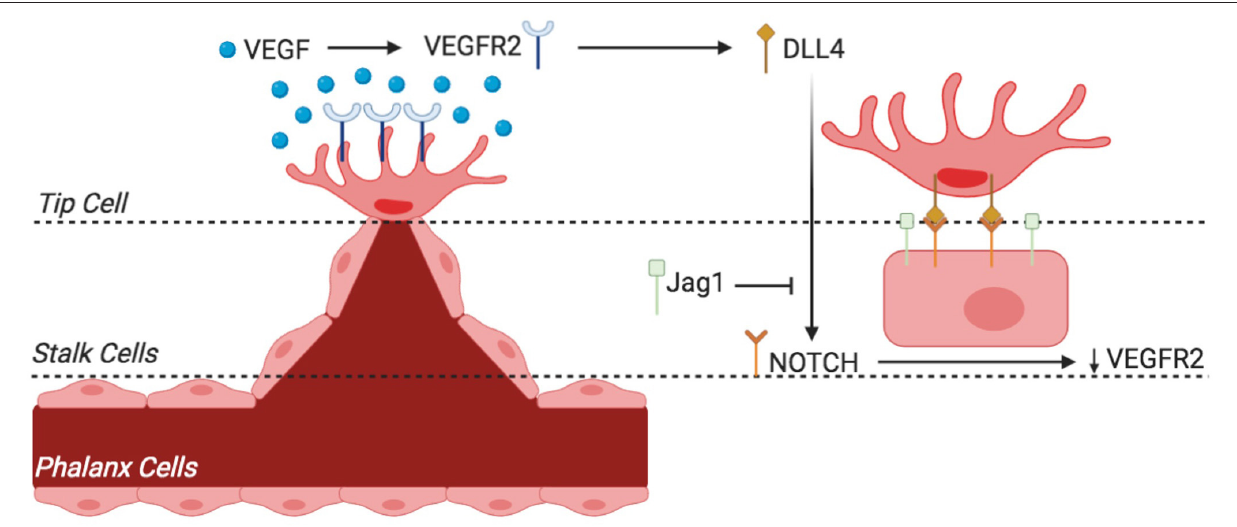
FIGURE 6 | Sprouting angiogenesis and phenotypic switching of tip vs. stalk endothelial cell (EC) by VEGF-Notch signaling. The endothelium of existing blood vessels is activated by VEGF, and phenotypic switching from tip cell to stalk cells occurs through the mechanism described. VEGF binds to VEGFR2 and activates EC to become tip cell that is situated at the migrating tip of the sprout (and hence called tip cell). VEGFR2 activation results in the expression of notch ligand DLL4. DLL4 activates notch receptors in adjacent EC, which reduces VEGFR2 expression and thus decreases sensitivity to VEGF. This loss of VEGF sensitivity in EC results in loss of tip cell phenotype rather helps activate stalk cell phenotype. The equilibrium between the Jag1-notch and DLL4-notch signaling is essential for angiogenesis regulation and differentiation of stalk cell to tip cell. VEGF, vascular endothelial growth factor; VEGFR2, VEGF receptor 2; Jag1, jagged-1; DLL4, delta-like 4.